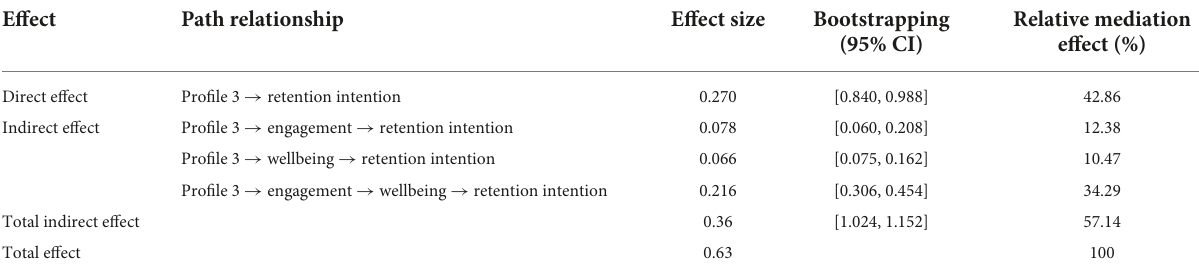
TABLE 6 Models’ effects